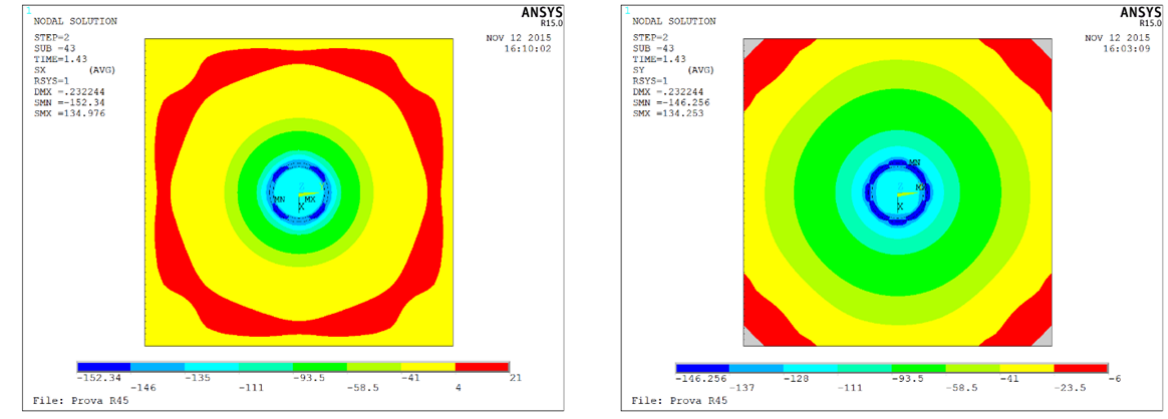
Fig. 2Facing-up surface: a) radial stresses; b) tangential stresses.